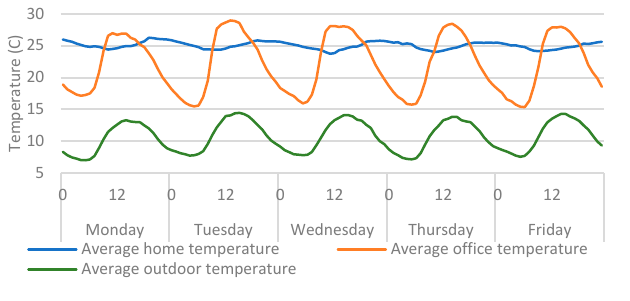
Figure 3. Average hourly temperatures (per weekday) from each temperature source (home, office, and outdoor). Qualitative findings are displayed alongside the quantitative data for context.